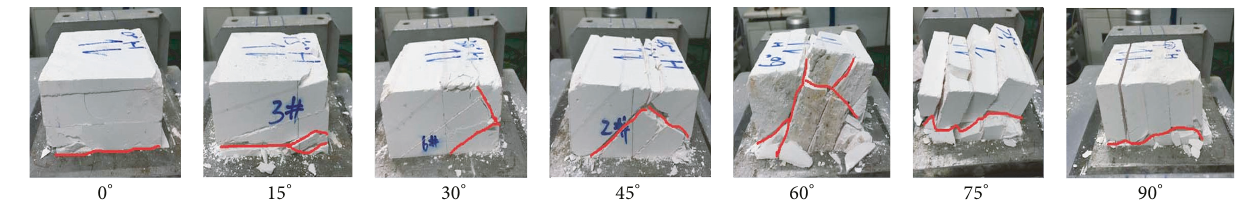
Figure 16: Failure of the physical specimens in the direct shear